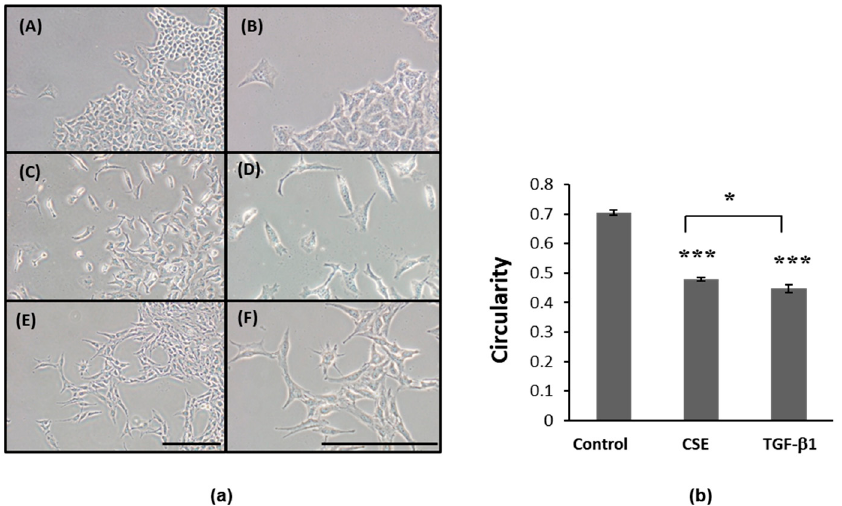
Figure 3. Morphological changes in A549 cells responding to CSE or TGF- β 1. ( a ) A549 cells changed from tightly packed cobblestone epithelial-like shapes (A, B) to more isolated, irregular, and elongated shapes after 72 h of exposure to CSE (C, D) or TGF- β 1 (E, F). ( b ) Computed circularity of cells in ( a ). A total of 100 cells from each culture condition were measured, and the results comprise data from three independent experiments. Scale bar = 200 μ m, * p < 0.05, comparing CSE and TGF- β 1; *** p < 6.0 × 10 − 5 compared to control. CSE, cigarette smoke extract.